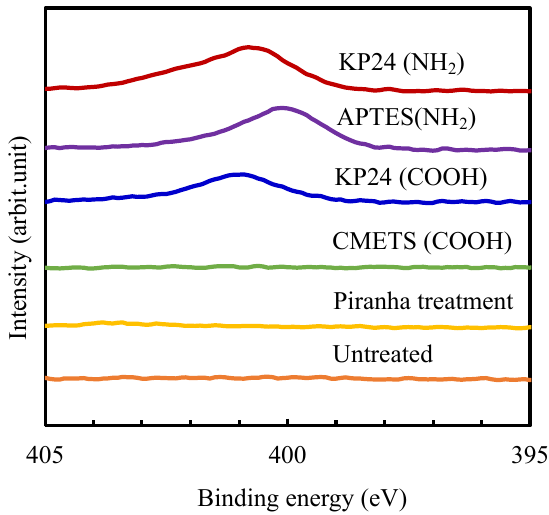
Figure 2. Contact angle of KP24-immobilized glass surface.